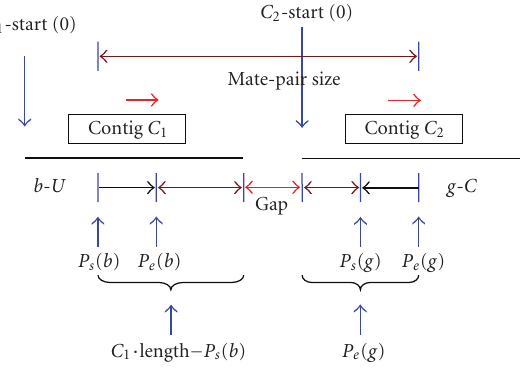
Figure 3: Estimation of the gap size between contigs when b has direction U and g has direction C . The gap size between C 1 and C 2 can be